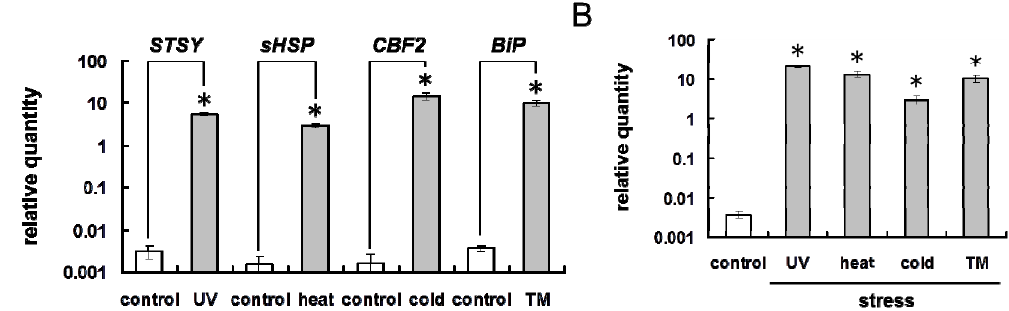
Figure 3. Environmental stresses induce ER stress response in plant cells. ( A ) Expression of stress marker genes in grape cultured cells exposed to environmental stresses. UV radiation, heat stress, and cold stress upregulated STSY , sHSP , and CBF2 expression in grape cultured cells, respectively. Tunicamycin (TM) induced luminal binding protein ( BiP ) expression in grape cultured cells; ( B ) Expression of BiP in grape cultured cells exposed to environmental stresses. All of the environmental stresses examined upregulated BiP expression in grape cultured cells similarly to TM treatment. Bars indicate means ± standard errors calculated from three independent experiments. Mean values statistically different from control ( p < 0.01) are indicated by